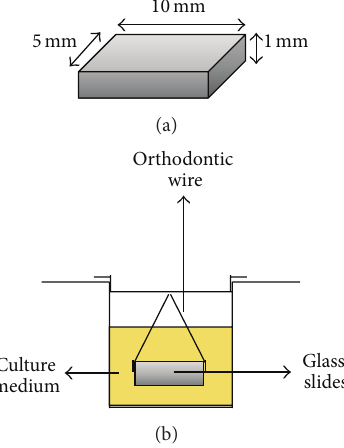
Figure 1: (a) Glass microscope slides. (b) Glass microscope slides on medium culture in the culture